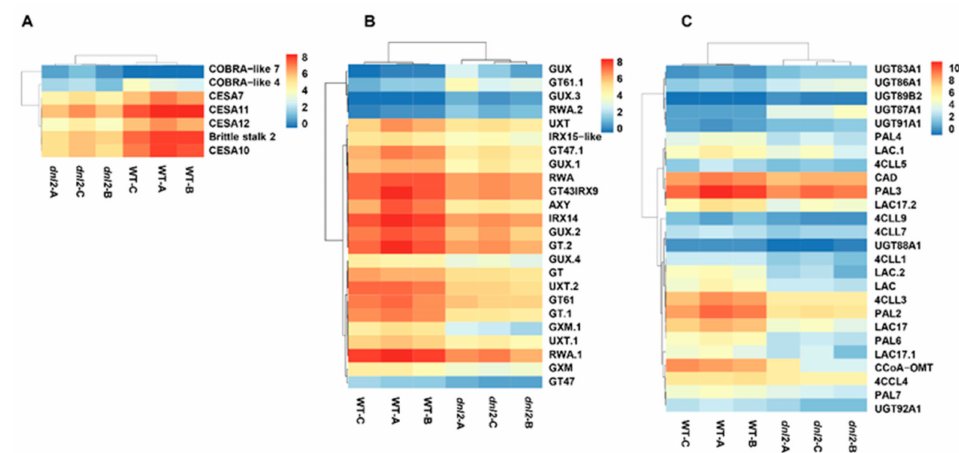
Figure 14. Heatmap of cell wall related DEGs. ( A ) Heatmap of DEGs involved in cellulose synthesis of the secondary cell wall. ( B ) Heatmap of DEGs participated in xylan synthesis. ( C ) Heatmap of DEGs participated in lignin